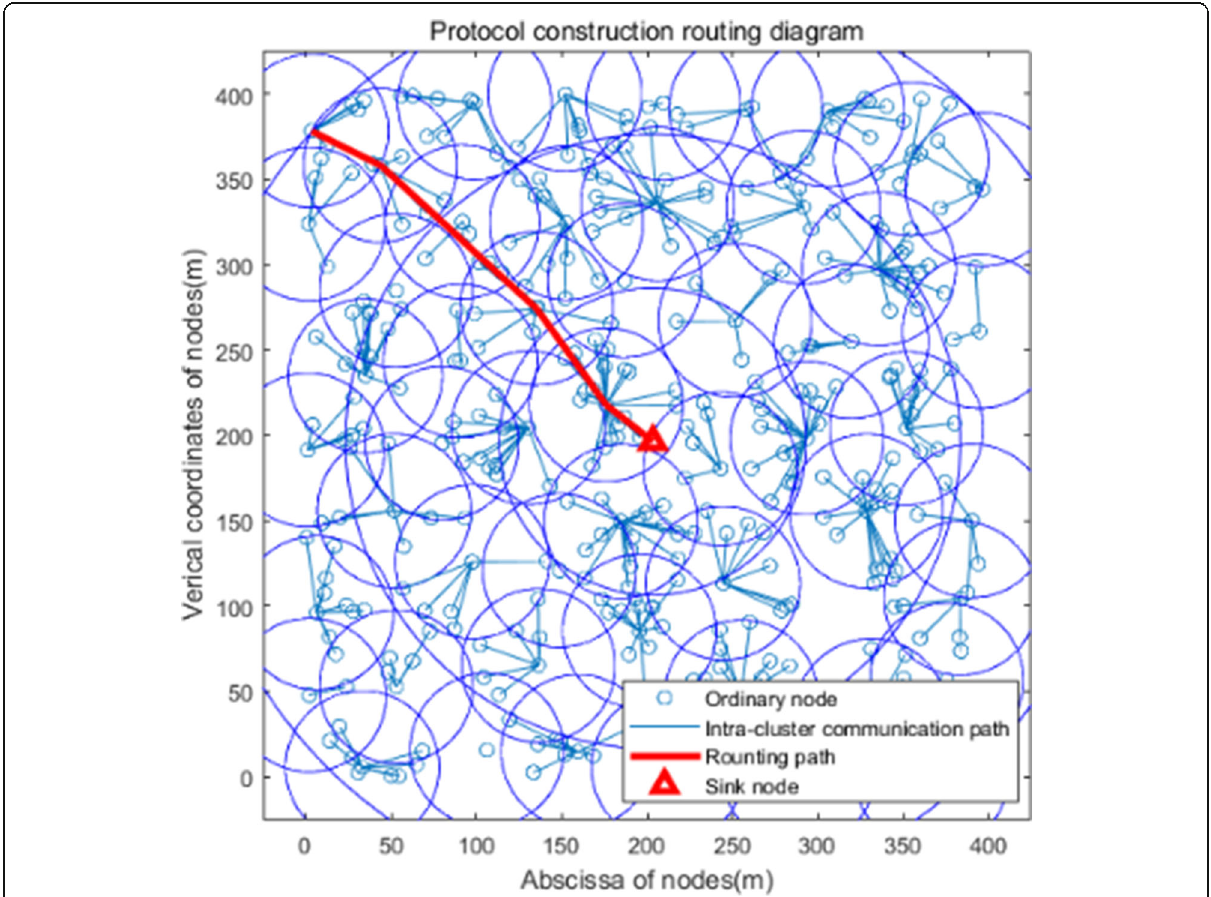
Fig. 7 Protocol construction routing diagram. The red curve is the data transmission route from the sending cluster head to the sink